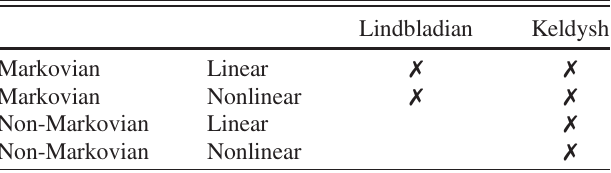
theoretical formulations. The inclusion of non-Markovian proc- esses (required, e.g., to describe the relaxation toward a quantum thermal distribution) is beyond the scope of the Lindbladian description but can be addressed within the Keldysh path integral